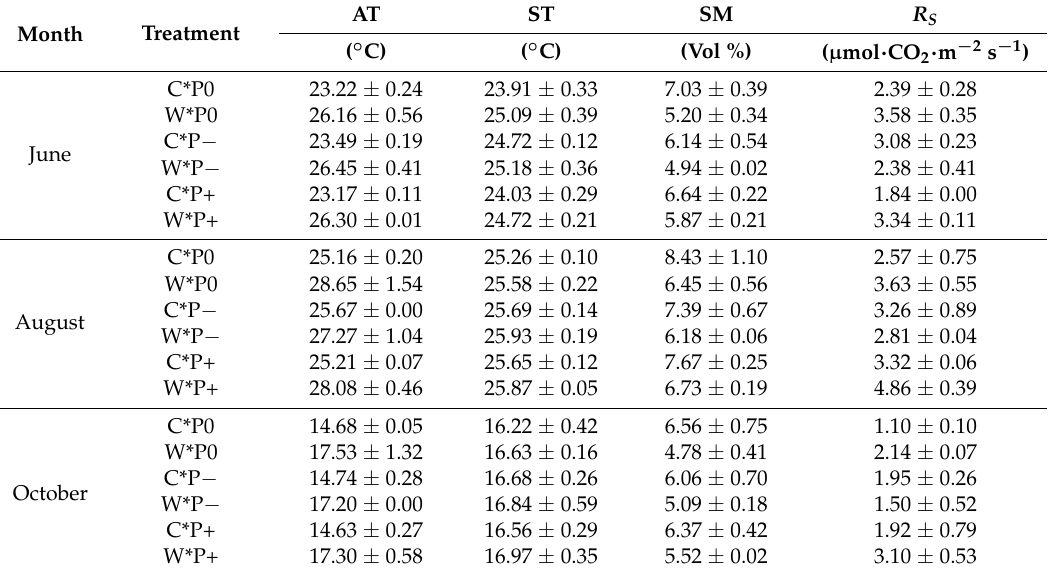
Table A1. Mean air temperature (AT), soil temperature (ST), soil moisture (SM), and soil respiration (R S ) measured in June, August and October, 2015 under different treatments, presented as mean ± standard